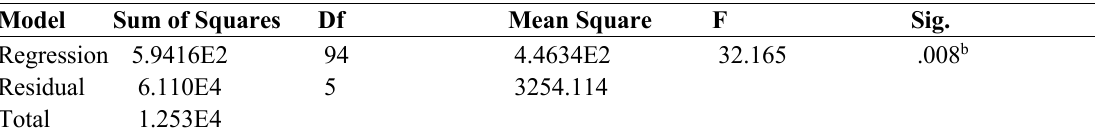
Table 3: ANOVA Model Sum of Squares Df Mean Square F Regression 5.9416E2